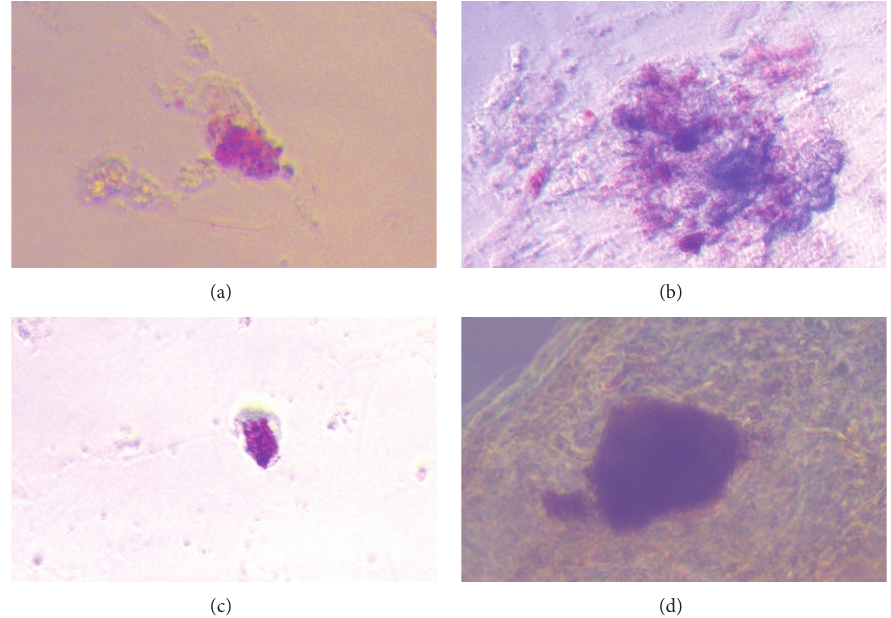
Figure 4: Staining of IPCs by diphenylthiocarbazone (dithizone). The dithizone staining was performed at 18th day. Red staining indicates insulin positivity in aggregated cells ( × 40